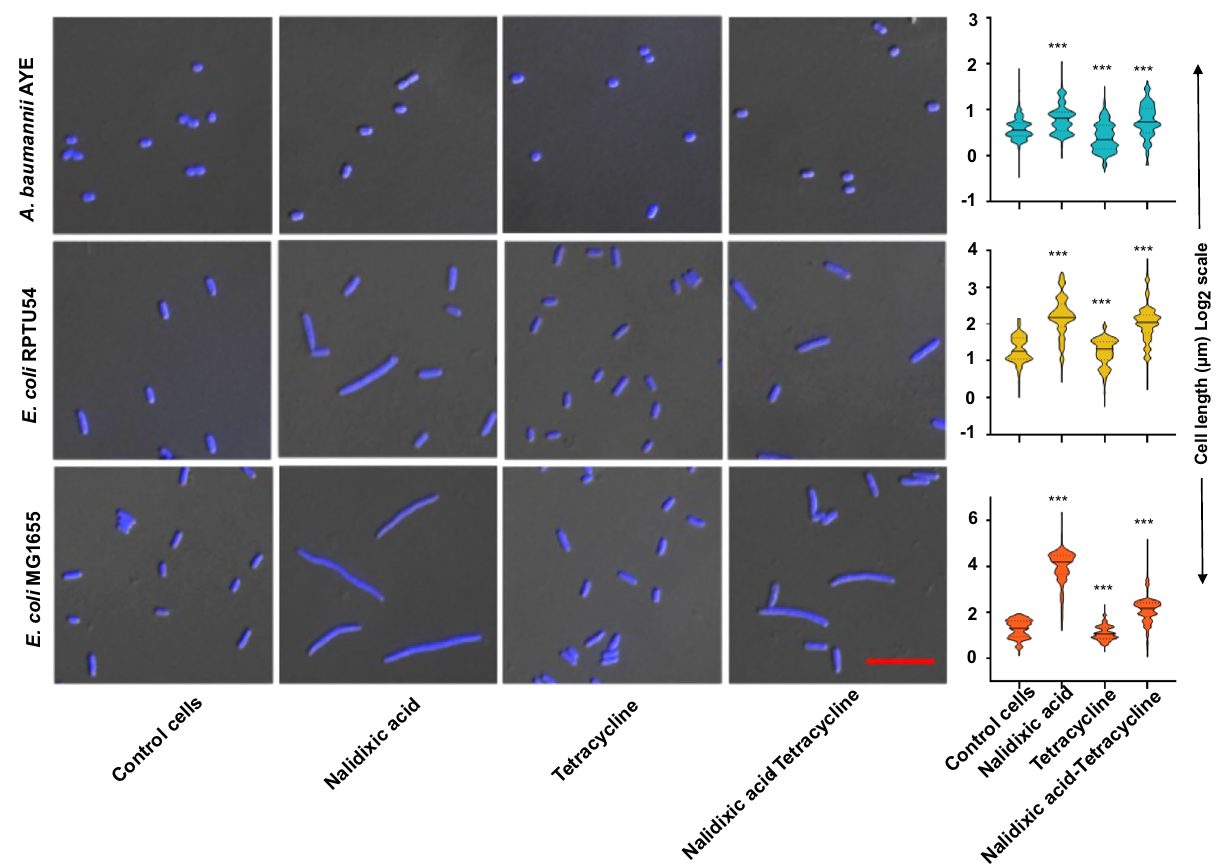
Fig. 4 Cell length heterogeneity under nalidixic acid and tetracycline combination. Representative differential interface contrast (DIC) combined with fl uorescence microscopy images of DAPI-stained (blue) A. baumannii AYE, E. coli MG1655, and E. coli RPTU54 cells growing in the absence of antibiotics (control cells) or in the presence of DNA synthesis inhibitors (nalidixic acid), translation inhibitor (tetracycline), or in a combination of both. Cell length displays the highest variability in the presence of DNA synthesis inhibitor but not in the presence of the translation inhibitor. All antibiotic concentrations were used at 0.75× MIC. Scale bar represents 10 µ m. Morphometric analysis of cell length shown as bean plots. Major solid lines represent the medians, dotted lines represent 1/4 th and 3/4 th quartile. Minimum 500 cells were analyzed in each group. P < 0.001 for all three groups, one-way ANOVA followed by the Kruskal – Wallis post test was